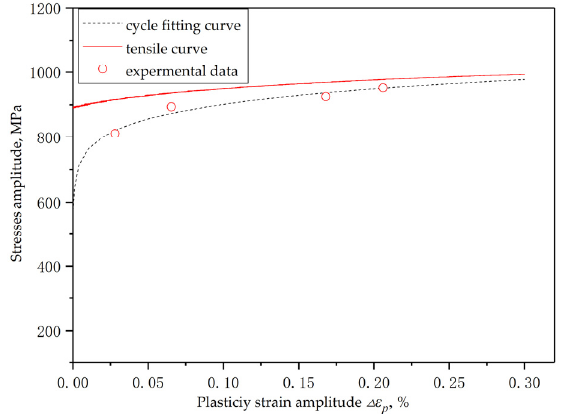
Figure 5. Comparison of uniaxial tension and cyclic stress–strain curves.